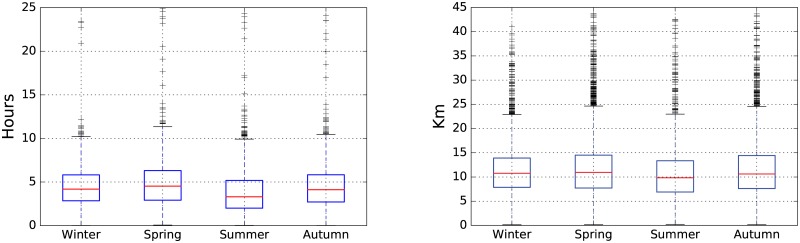
Seasonal analysis of hiking duration and length.Box plot figures: duration (left) and length (right).